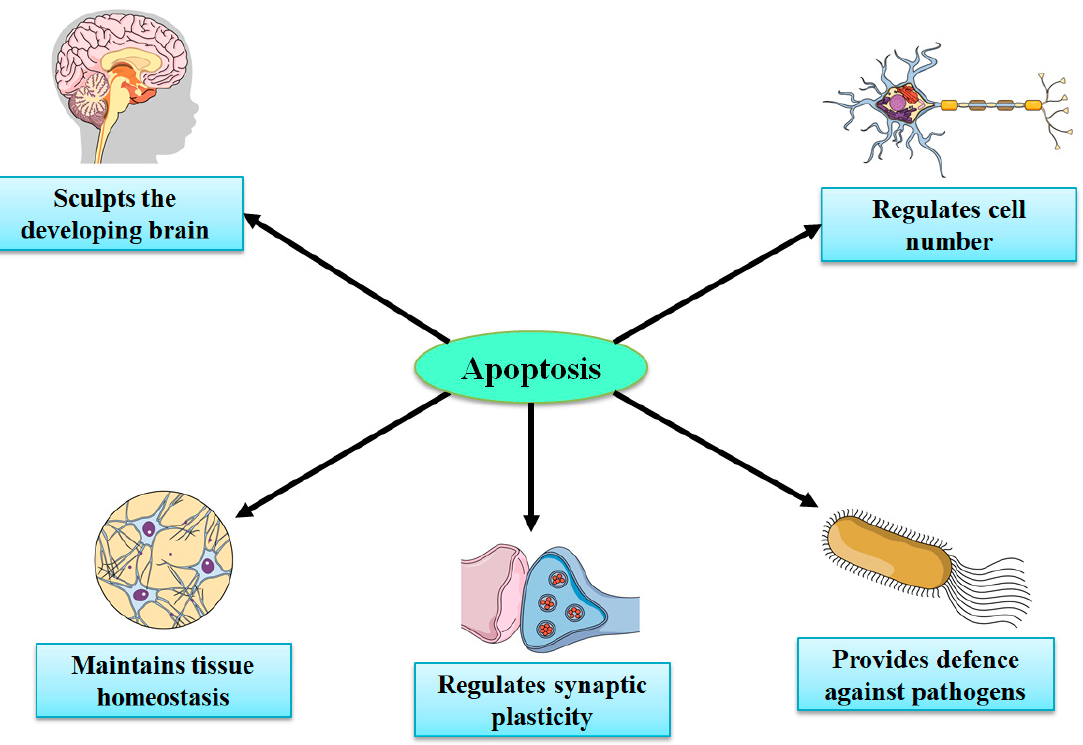
Figure 3. Important roles of apoptosis in the development of the central nervous